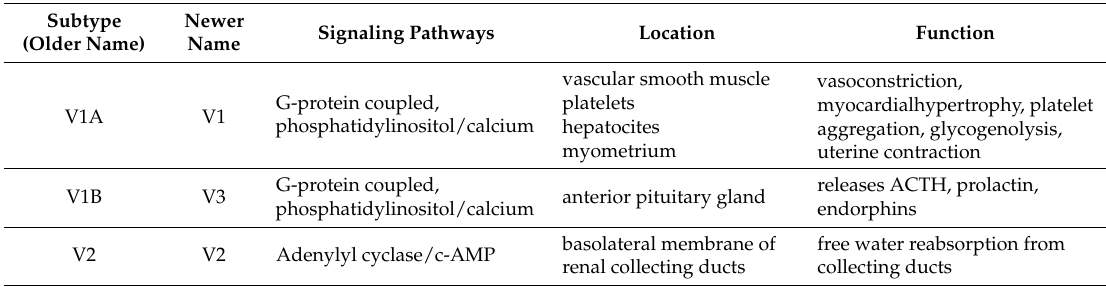
Table 3. Vasopressin receptor location and functions.